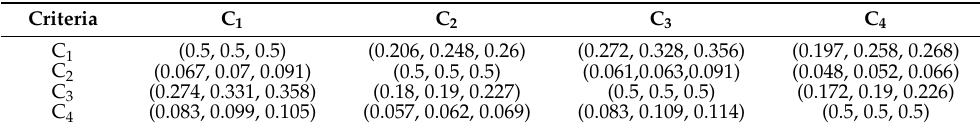
Table 7. Fuzzy weights of criteria with respect to the overall goal.